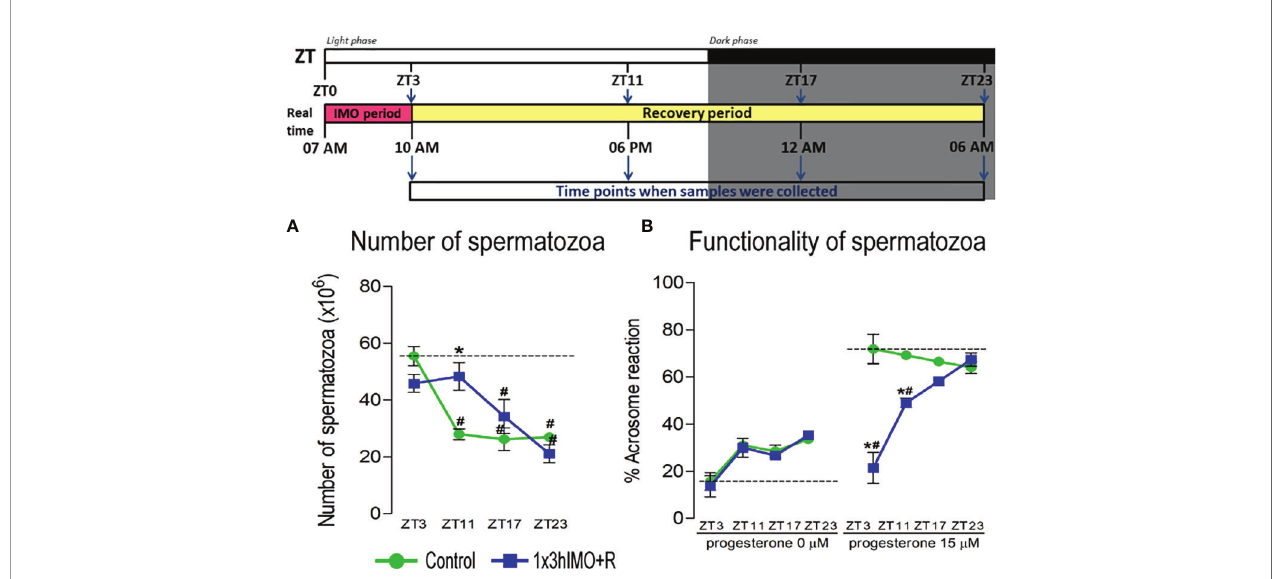
FIGURE 2 | The acute psychophysical stress by immobilization (IMO) decreases functionality and number of spermatozoa in different time points after the IMO stress. Number of spermatozoa (A) isolated from caudal epididymides of unstressed rats (control) and rats subjected to acute immobilization stress once for 3 h (1x3hIMO) with recovery periods of 0, 8, 14 and 20 h. (B) The functionality of spermatozoa (% of acrosome reacted spermatozoa) isolated from control and acutely (1x3hIMO) stressed rats. Capacitated spermatozoa were stimulated with progesterone (PROG 15 µM) in parallel with spermatozoa not treated with progesterone (PROG 0 µM). Blue staining in the acrosome region of the head indicated intact acrosome, whereas spermatozoa without blue staining in the acrosome region were considered to be acrosome reacted. Data are presented as green dots connected with a green line for the control group, and blue squares connected with a blue line for the 1x3hIMO group, and are mean ± SEM values of two independent in vivo experiments. Statistical signi fi cance was set at p < 0.05: * vs. the control group of the same time point, # vs. the control group of ZT3 time